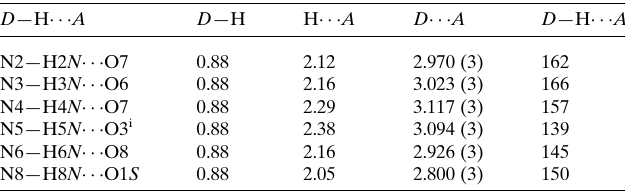
Table 1 Hydrogen-bond geometry (A˚ , (cid:4) ).